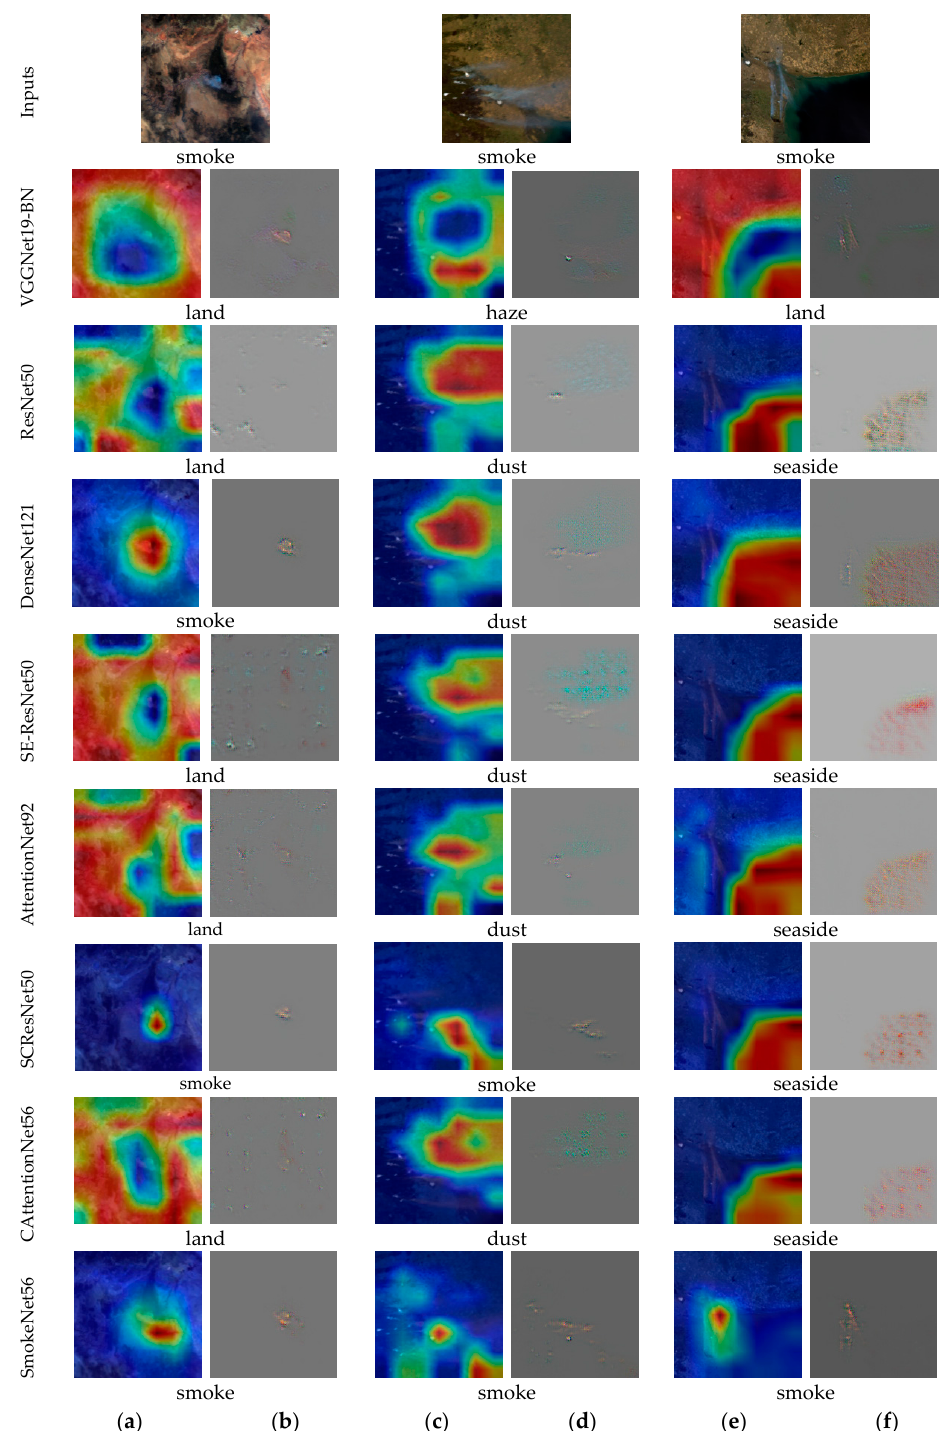
Figure 5. Comparison of gradient-weighted class activation mapping (Grad-CAM) and Guided Grad-CAM visualizations for the eight models. The first row presents the input smoke images and the remaining rows show the visualizations for the models listed on the left. ( a ), ( c ), and ( e ) columns are the Grad-CAM results highlighting the important regions in red; ( b ), ( d ), and ( f ) columns are the high-resolution class-discriminative visualizations of Guided Grad-CAM. The image class predicted by each model is displayed below the